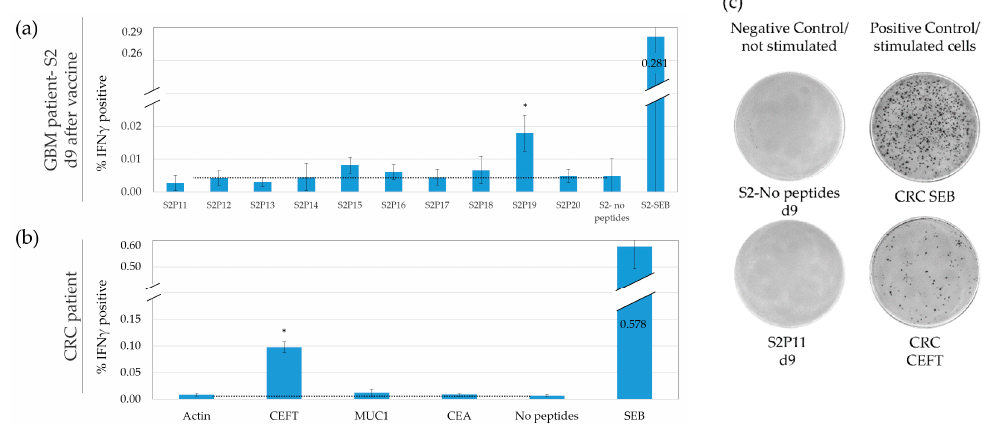
Figure 2. Monitoring responses to vaccinated peptides and to peptide pools using ELISpot: PBMC samples obtained from a glioma patient, 9 days after vaccination with set 2 vaccine ( a ) and PBMC from a CRC patient ( b ) were cultured with or without peptides/peptide pools, with the positive control CEFT peptide pool or with the SEB superantigen. Spot-forming units (SFU) were micrographed and quantified. ( a ) Mean and STD of triplicates from glioma vaccine set 2, ( b ) mean and STD of triplicates from a CRC patient. A dotted reference line was drawn from the no-peptides groups. An asterisk represents a response that is significantly different from the no peptides group (t-test, P < 0.05). ( c ) Representative micrographs of IFN γ ELISpot: positive control SEB and CEFT; response to specific peptides and to negative control-no peptides.